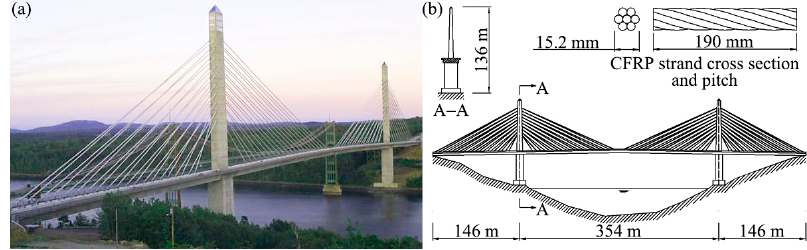
Figure 20. Penobscot Narrows Bridge, ( a ) photo (photo credit: MOT) and ( b ) sketch.